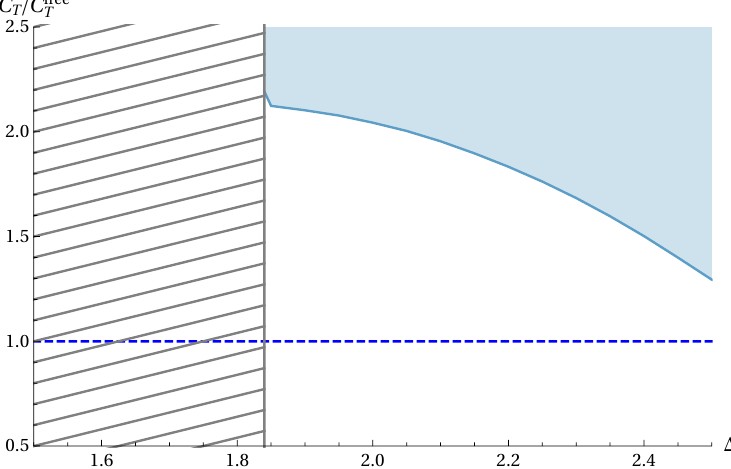
Figure 20 . Lower bound on the central charge normalized to the free value under the assumptions that relevant scalars are absent, both in the neutral and charged sector. The shaded region is allowed. The (cid:1)